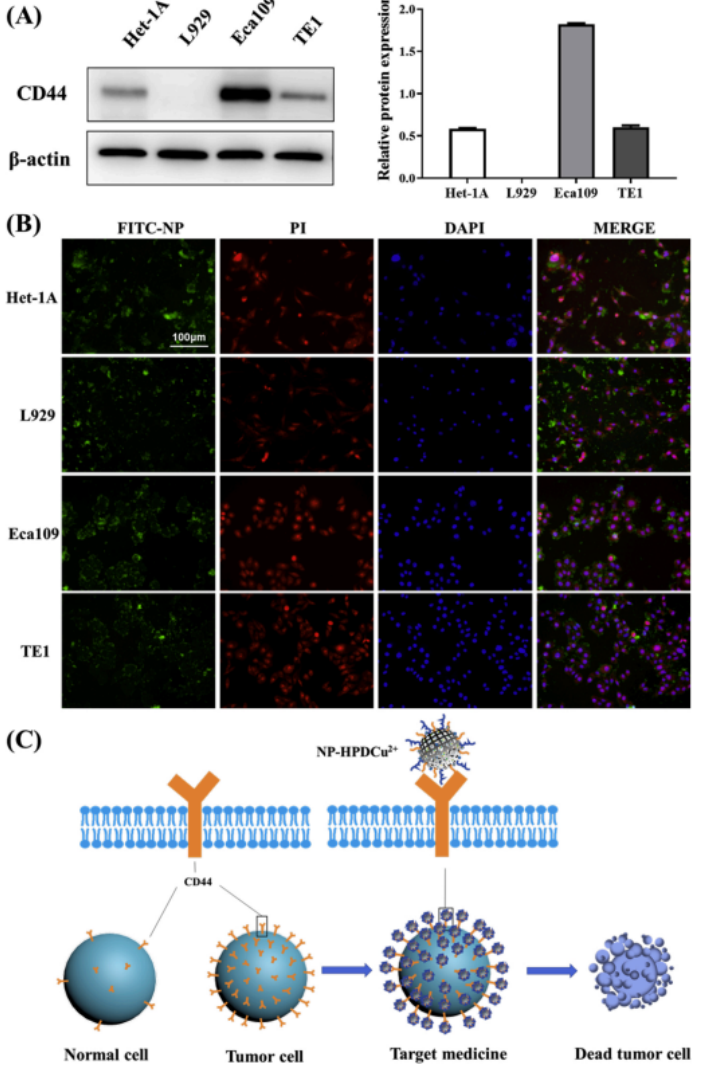
Figure 5. ( A ) Western blot of CD44 expressed on the Het-1A, L929, Eca109, and TE1 (mean ± SD, n = 3); ( B ) Fluorescence images of Het-1A, L929, Eca109, and TE1 stained with FITC-labeled NP- HPDCu2+ (FITC-NP, green color), PI (apoptosis marker, red color) and DAPI (nucleus marker, blue color); ( C ) mechanism diagram of targeted killing tumor cells by NP-HPDCu2+ nanoparticle.